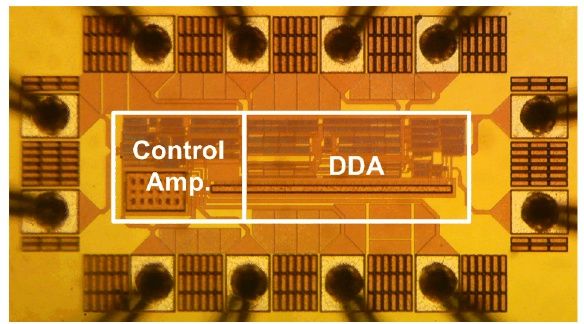
Figure 11. Micrograph of the fabricated potentiostat.